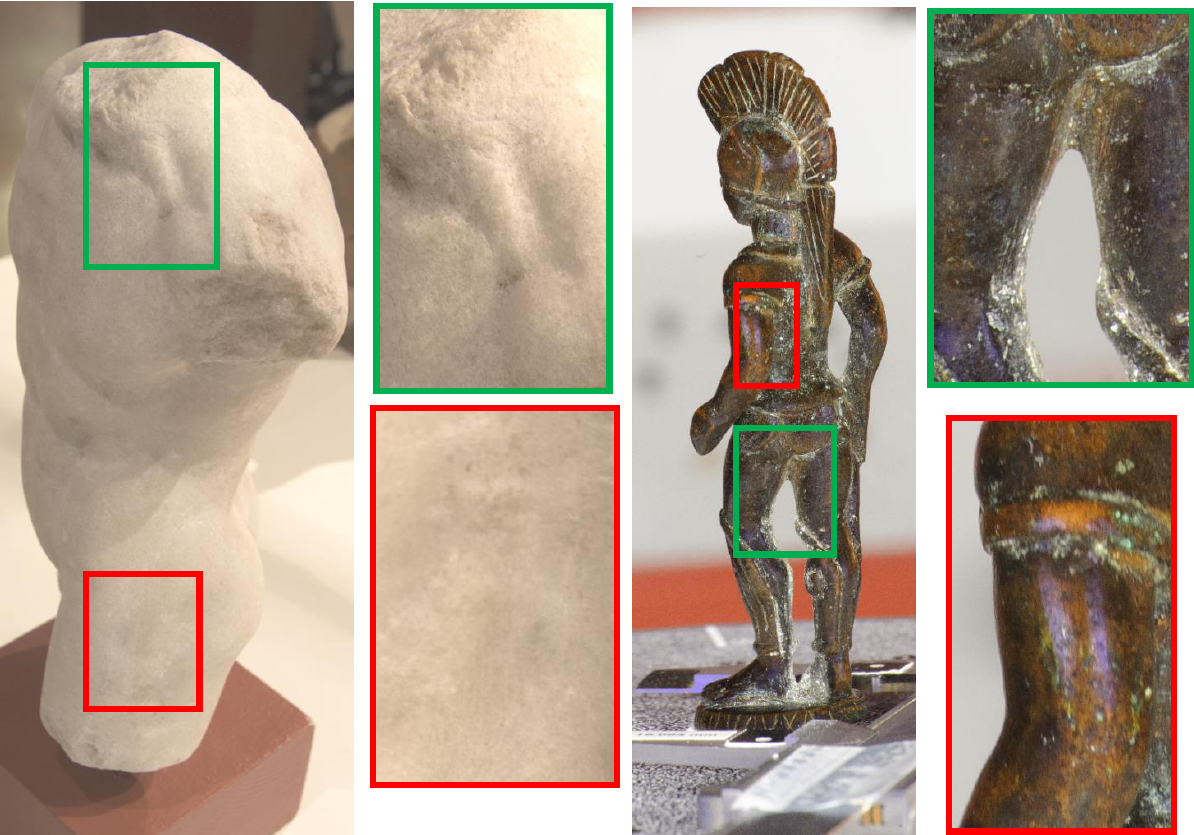
Figure 1: The two surveyed statues. Examples of very short depth of field on marble and bronze